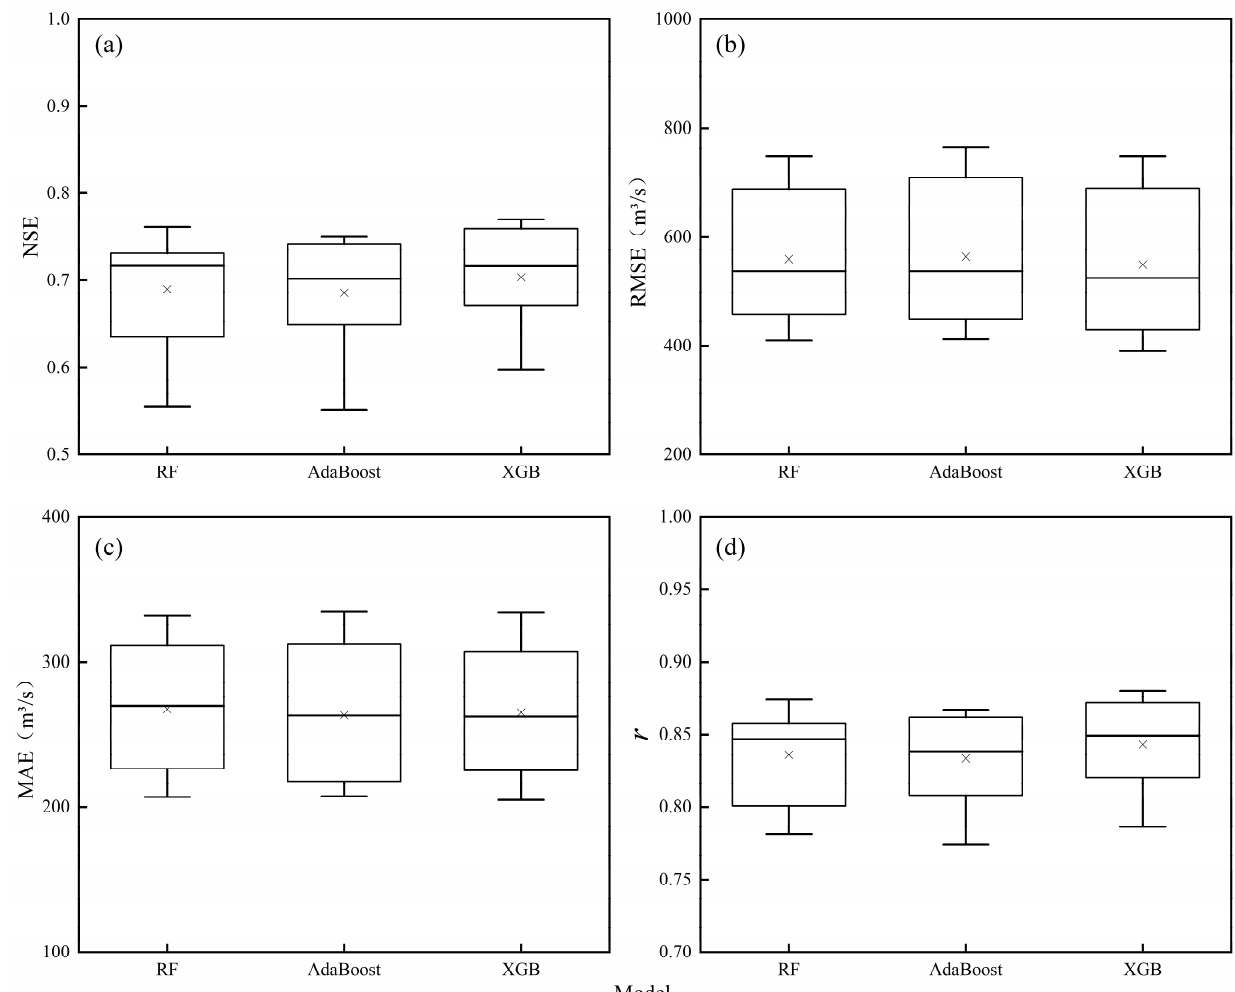
Figure 6. Box plots showing the evaluation criteria in different models. Each box is calculated from 10 folds of the training data model runs. The model performances vary in terms of ( a ) NSE, ( b ) RMSE, ( c ) MAE, and ( d ) r . The × marks inside the boxes are the average values. Table 2. Evaluation criteria for three base models (the values of RMSE and MAE are in m 3 /s).